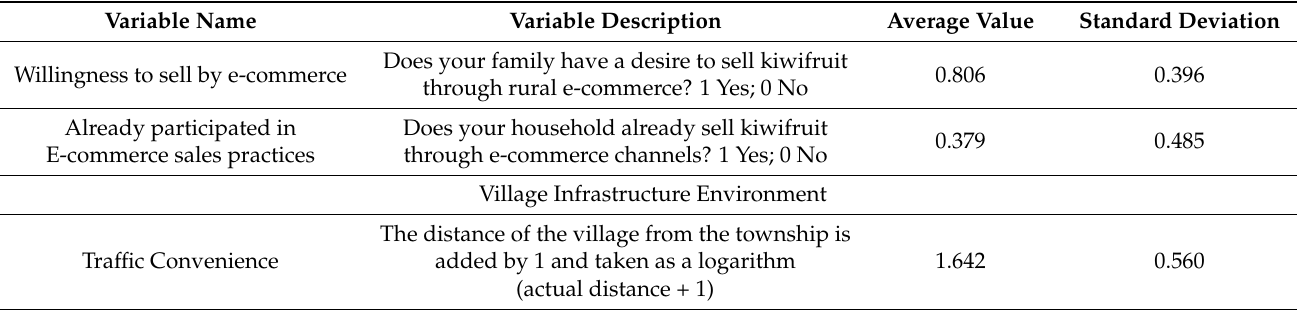
Figure 2. Distribution of farmers’ willingness to participate in e-commerce sales and already partic- ipated in e-commerce sales behavior. Table 2. Variable selection and descriptive statistics.